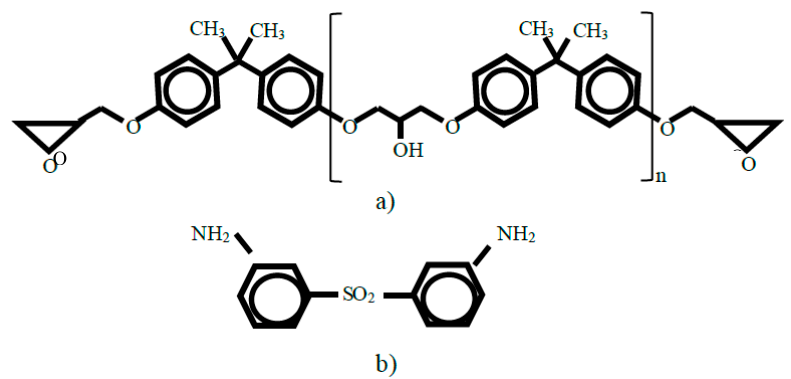
Figure 3. Structural diagrams of diglycidyl ether of bisphenol A (DGEBA) ( a ) and 3,3 ′ diamino diphenyl sulfone (3,3 ′ DDS) ( b ). Table 1. Summary of system ingredients prior to crosslinking: 100% excess epoxy and stoichiometric formulations are indicated by “XS” and “STOI”, respectively. Resin molecule degrees of polymerization is designated by “n0” and